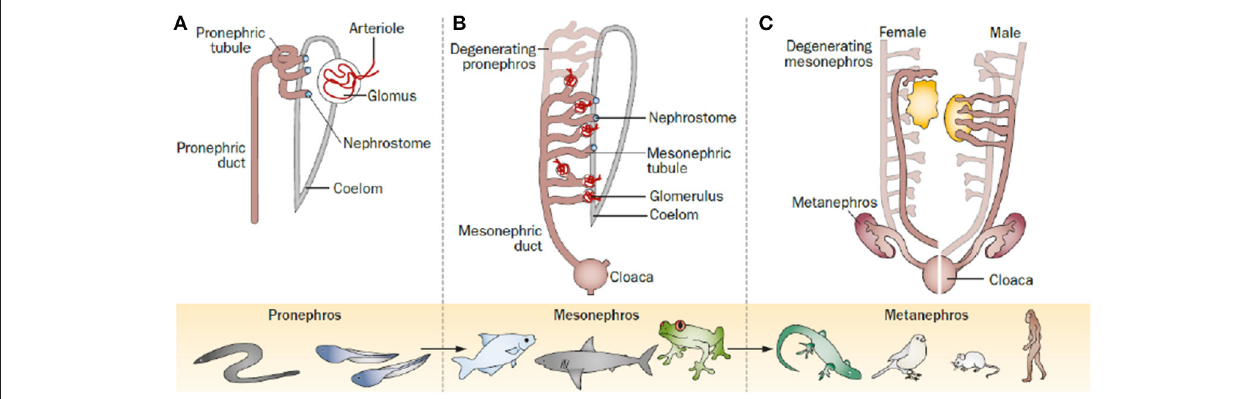
FIGURE 1 | The kidney through evolution, as it proceeded through a series of successive phases, each marked by the development of a more advanced kidney: the pronephros, mesonephros, and metanephros. (A) The pronephros is the most immature form of kidney; it represents the first stage of kidney development in most animal species, but became functional only in ancient fish, such as lampreys or hagfish, or during the larval stage of amphibians. (B) The mesonephros represents the second stage of kidney development in most animal species, and represents the functional mature kidney in most fish and amphibians. It is made up of an increased number of nephrons, usually dozens to hundreds. (C) The metanephros represents the last stage of kidney development after degeneration of the pronephros and mesonephros in reptiles, birds and mammals, where it persists as the definitive adult kidney; it consists of a substantially increased number of nephrons, usually from thousands to millions. Romagnani et al. progenitors: an evolutionary conserved strategy for kidney regeneration. Reprinted by permission from Macmillan Publishers Ltd: ( Romagnani et al.,